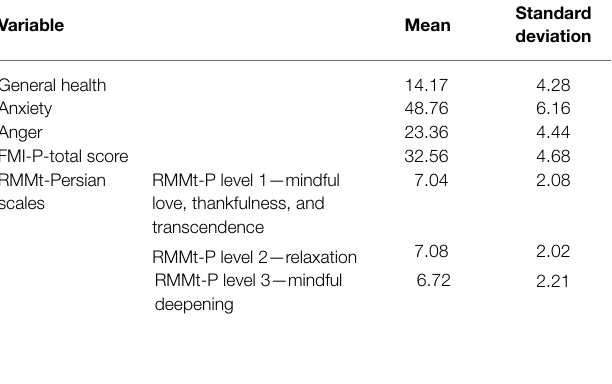
TABLE 1 | Summary of descriptive statistics for main study variables ( n =